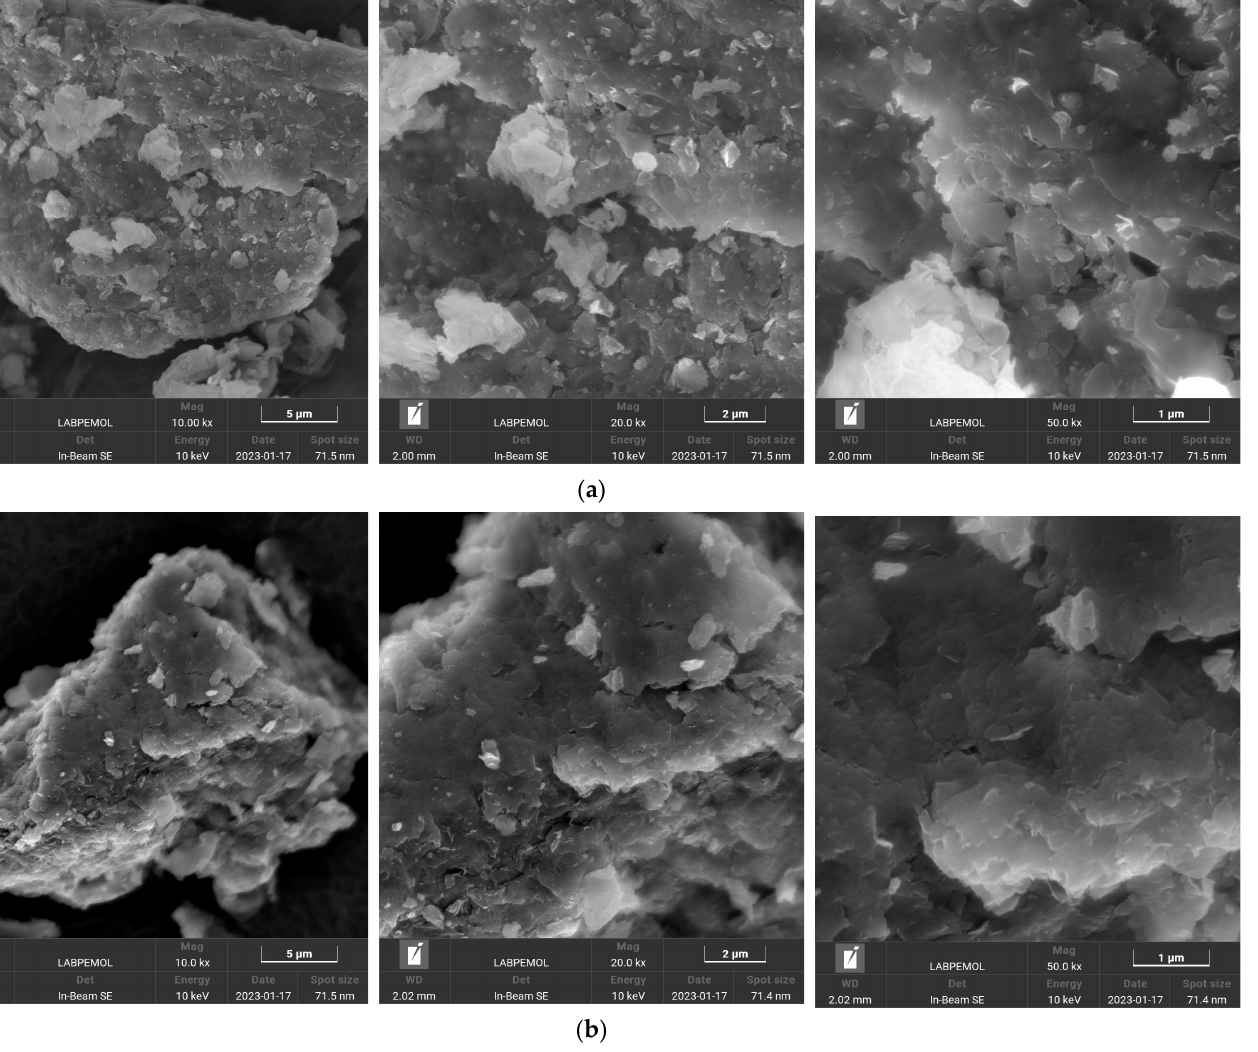
Figure 7. SEM images of ( a ) Mt and ( b ) Mt–RIF hybrid.